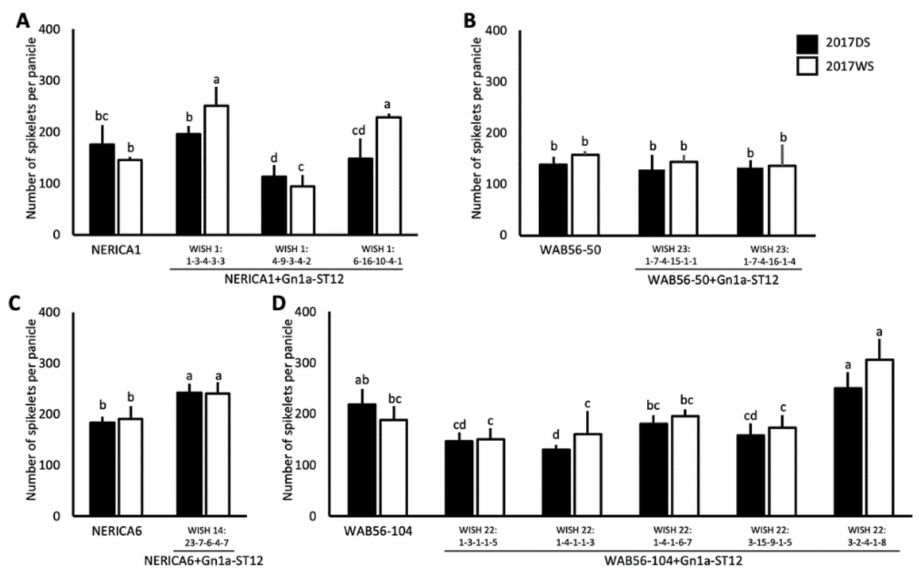
Figure 3. Number of spikelets per panicle (mean ± SD) of Gn1a-ST12 introgression lines in the genetic backgrounds of NERICA1 ( A ), WAB56-50 ( B ), NERICA6 ( C ), and WAB56-104 ( D ). Solid and white bars show the results in 2017DS and 2017WS, respectively. Different letters above the bar graphs indicate significant difference at p <